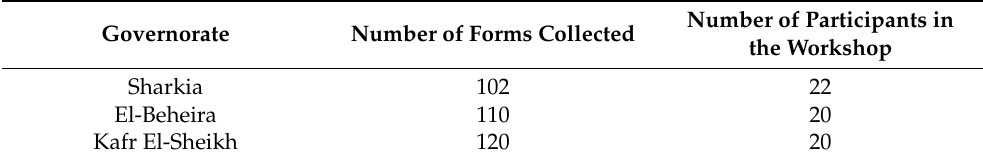
Table 1. Number of forms collected and farmers attending the workshops.